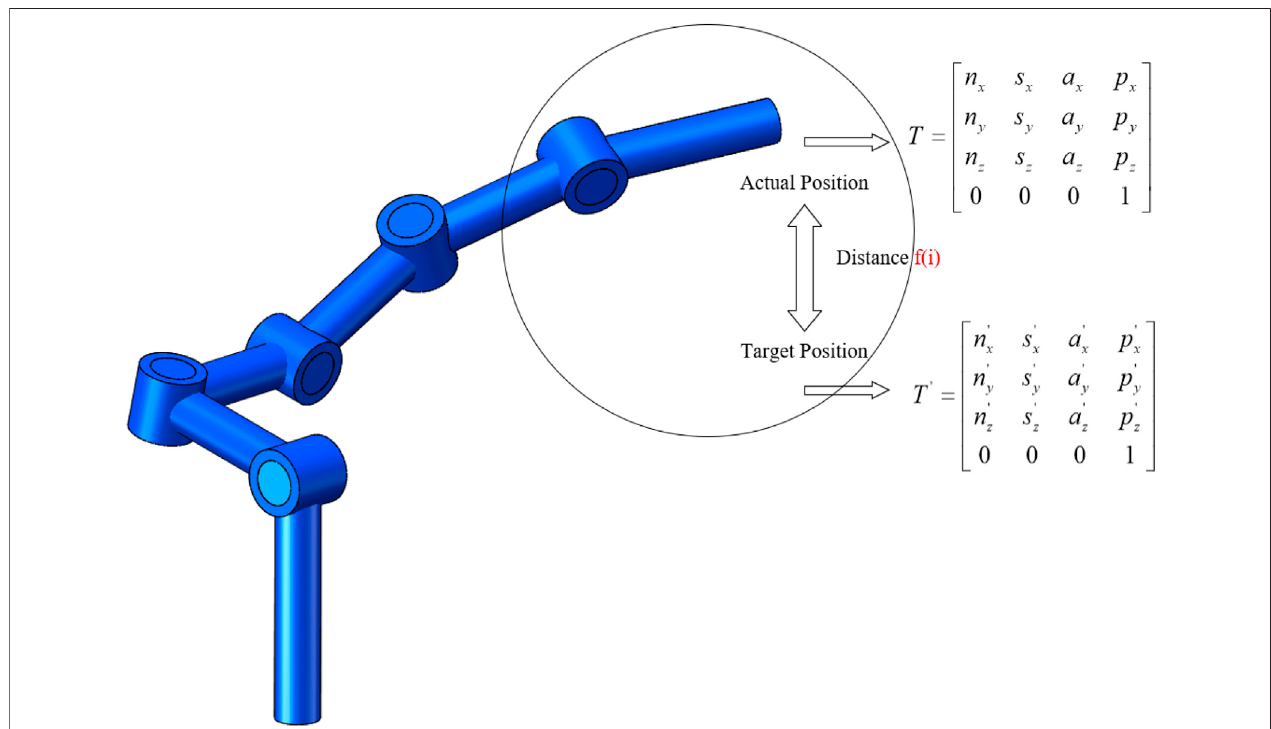
FIGURE 2 | Schematic diagram of the fi tness